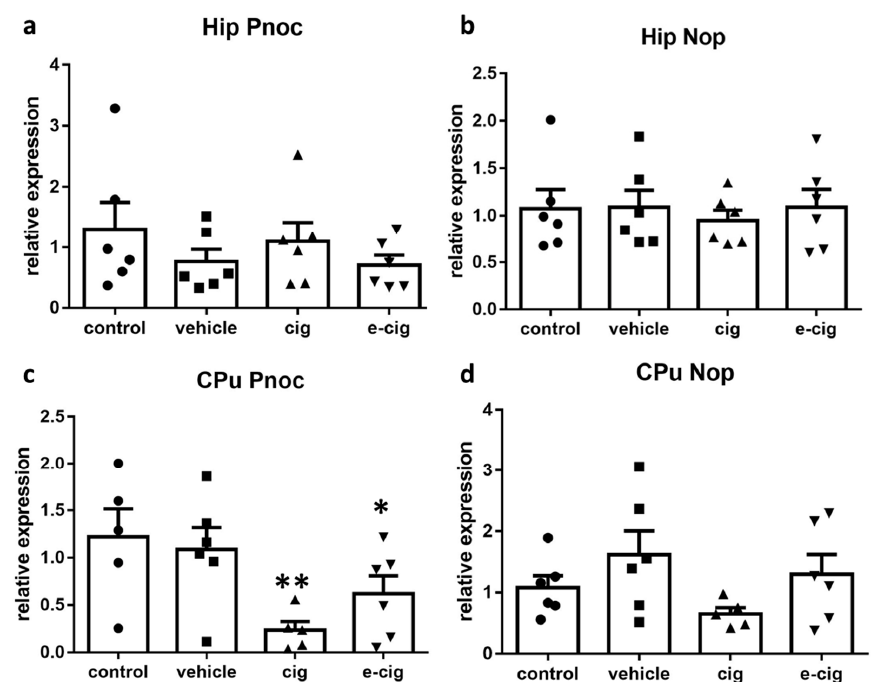
Figure 4. Relative mRNA levels of Pnoc ( a , c ) or nociceptin receptor Nop ( b , d ) after e-cigarette (e-cig, downward triangle) or cigarette (cig, upward triangle) exposure with respect to exposure to air (control, circle) or an e-cigarette administration vehicle (vehicle, square). The results displayed in panels a and b were obtained in the hippocampus, while panels c and d show the results from the CPu. The mice were exposed to cigarettes or e-cigarettes for 7 weeks, followed by a 60-day withdrawal. n = 4–6 for each group. **: p < 0.01, *: p < 0.05 in the Planned Comparison vs. control. Hip: hippocampus; CPu: caudate-putamen.